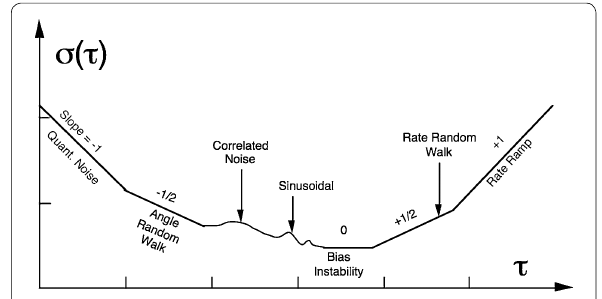
Fig. 1 Allan variance plot for typical data analysis. The cluster time of length τ could take different units in time, e.g. microseconds, seconds, minutes or hours as well as σ ( τ ), i.e. angular velocity, e.g. rad/s or for gyros, depending on sensor type (Hidalgo et al. 2012)